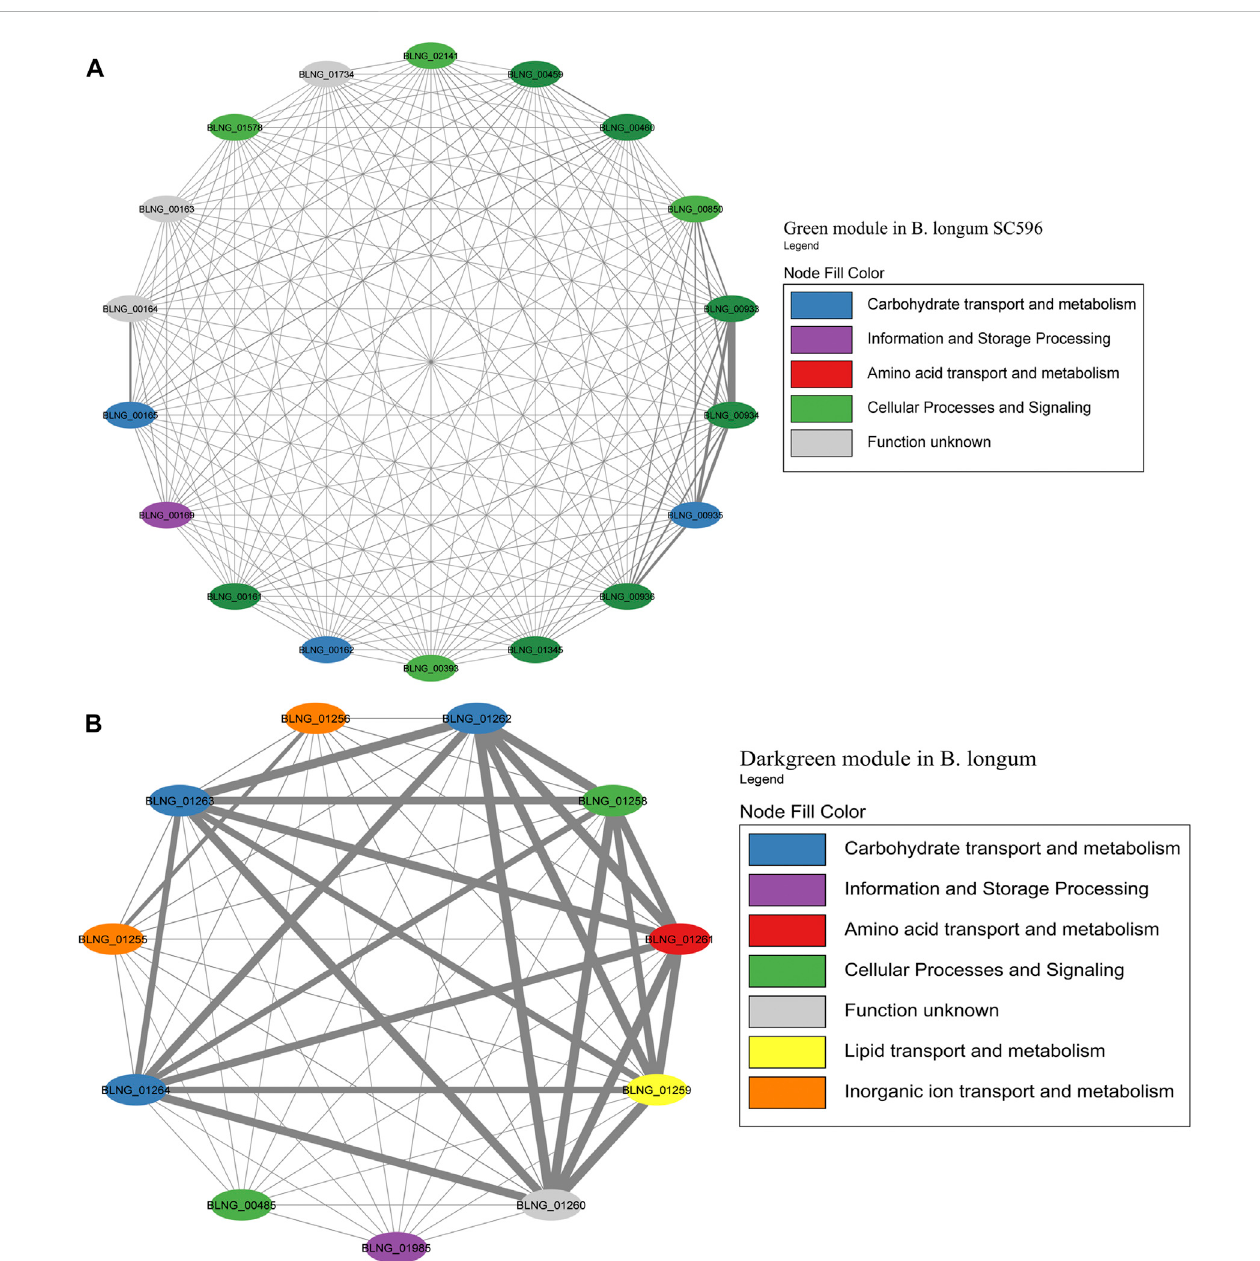
FIGURE 8 HMO-relatedco-expressionnetworksin B.bi fi dum . (A) Darkturquoiseand (B) Purplemodulefor B.bi fi dum SC555.AllNetworkconstructionconsistedof modulesweremanuallyanalyzed,andthosecontainingHMO-metabolizinggeneswereusedtocreateaco-expression network.Thisanalysisconsideredthe neighboring genes of each node with the highest